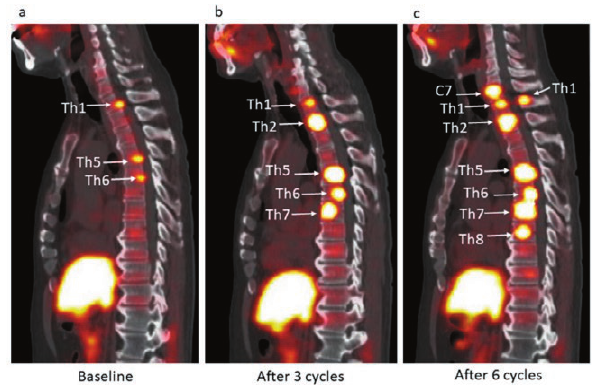
Figure 10. a to c clearly shows the progression of bone metastases during multiple cycles of treatment. The large bright spot in the lowest part of the figure is the normal liver which concentrates the 11 C-choline that is injected. Th is thoracic vertebrae, C is cervical vertebrae.